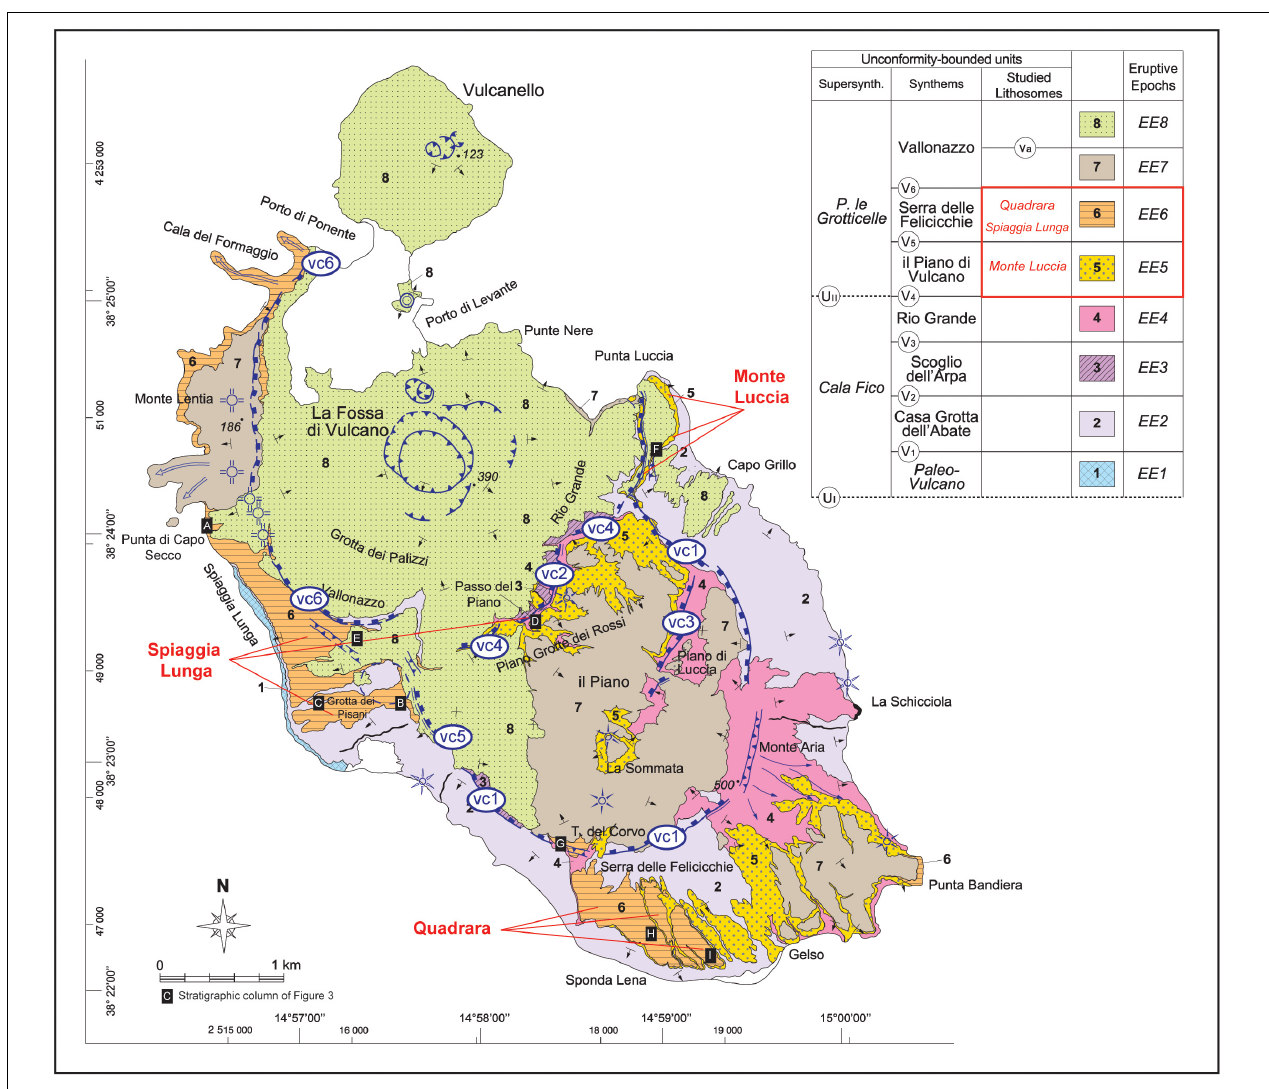
FIGURE 1 | Geological sketch map of the island of Vulcano (from De Astis et al., 2013). The studied areas of Monte Luccia, Spiaggia Lunga and Quadrara are indicated. vc = volcano-tectonic collapse. White letters in black box are referred to the stratigraphic columns of Figure 5